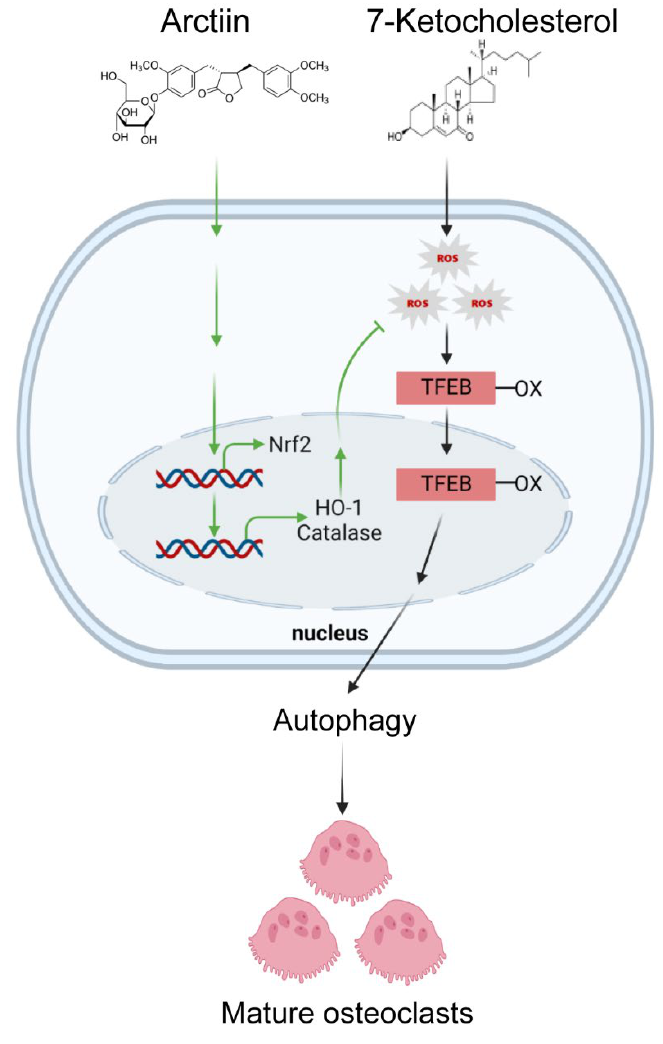
Figure 5. Arctiin attenuates the effects of 7-KC by decreasing the oxidized TFEB signaling pathway, thereby disturbing TFEB nuclear localization. Moreover, arctiin increases the expression of Nrf2, OCs, thus highlighting the therapeutic potential of arctiin to prevent cholesterol-induced bone loss.